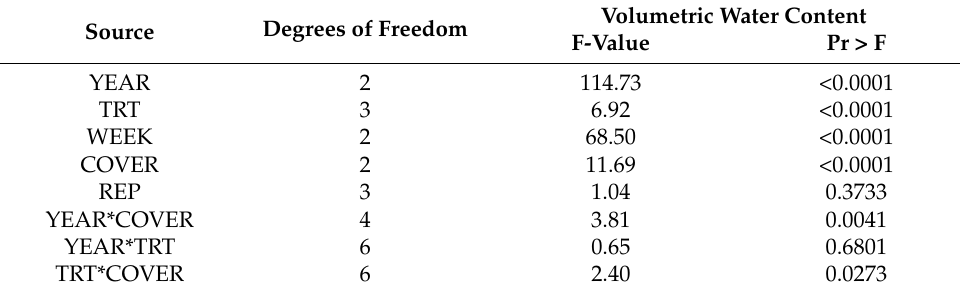
Table 9. ANOVA table for Volumetric Moisture Content.